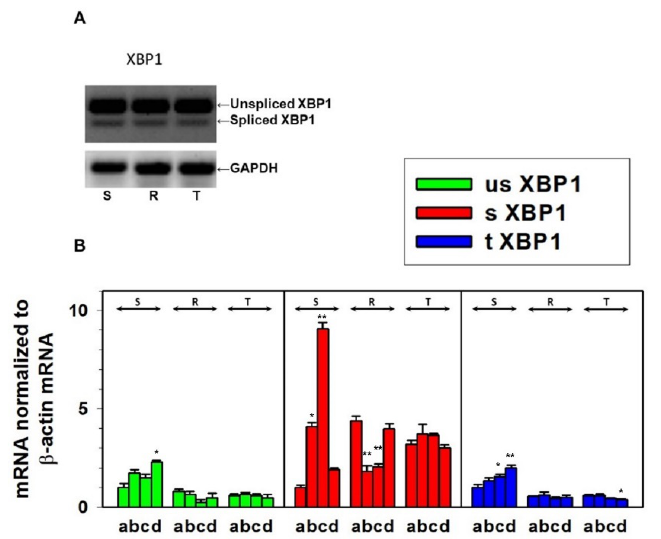
Figure 7. Detection of the unspliced and spliced variants XBP1 transcripts in S, R, and T cells: ( A ) RT- ( A ) RT-PCR identification of unspliced and spliced variants of XBP1 in S, R, and T cells in the absence